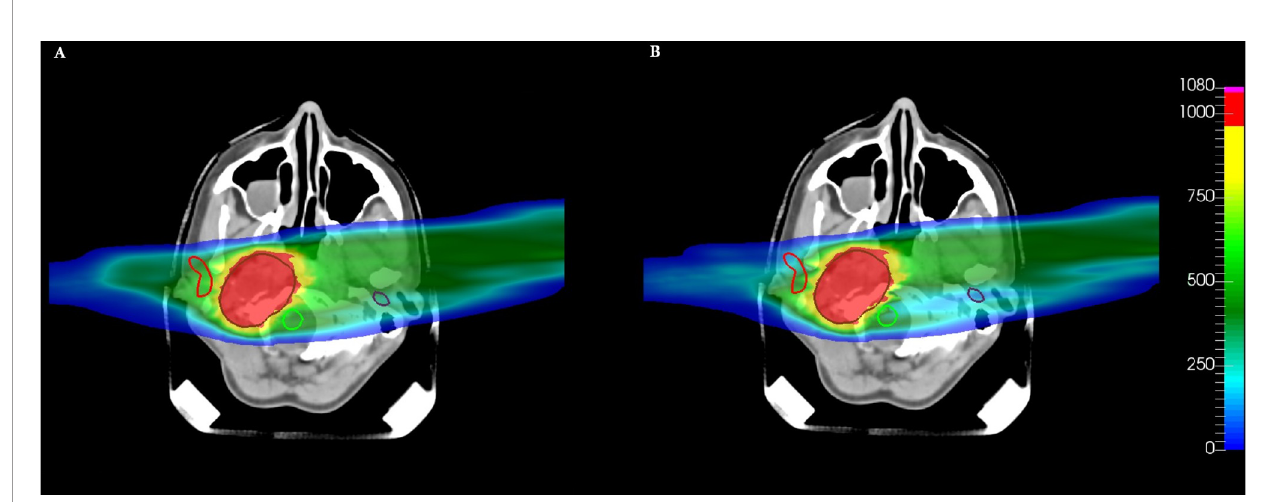
FIGURE 9 | Comparison of dose distributions on a CT slice for patient plan 335 considering both parotid glands, obtained with (A) voxel-dose-based and (B) generalized equivalent uniform dose (gEUD)-based optimization. The target (brown contour), the right parotid (red contour), the left parotid (violet contour), and the spinal cord (green contour) are shown. The dose levels are plotted in per mil of the prescribed dose.